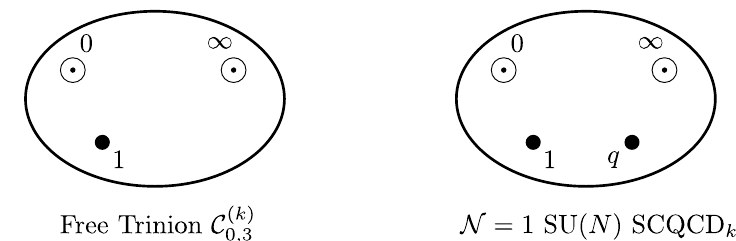
Figure 3 . The UV curves of the trinion and of the SCQCD k theories. They are 3, respectively 4-punctured spheres. The full punctures are depicted by (cid:12) and placed at t = 0 and t = 1 , while the simple punctures (cid:15) are at t = 1 and at t = q